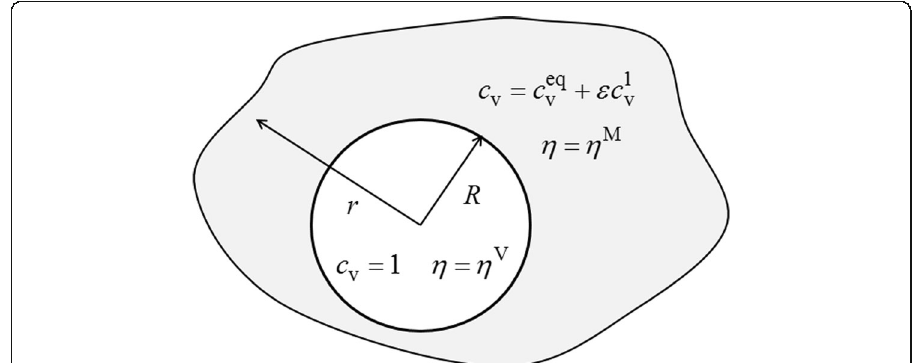
Fig. 4 A schematic of a spherical void growing in a solid matrix with a uniform supersaturation for the case of model C. The order parameter η takes on its equilibrium values η M and η V in the matrix and void,